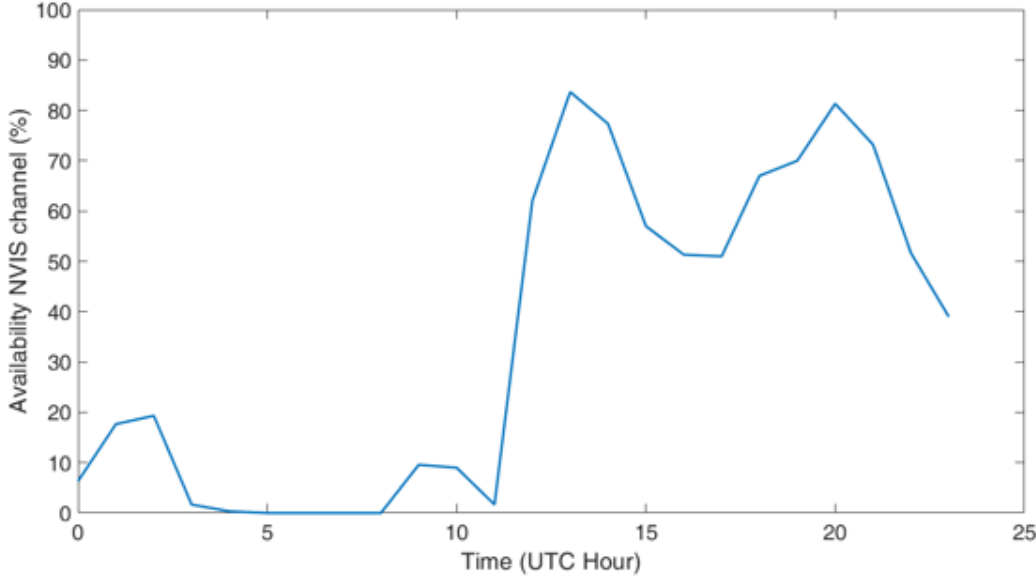
Figure 7. Availability of the Livingston Island NVIS channel.